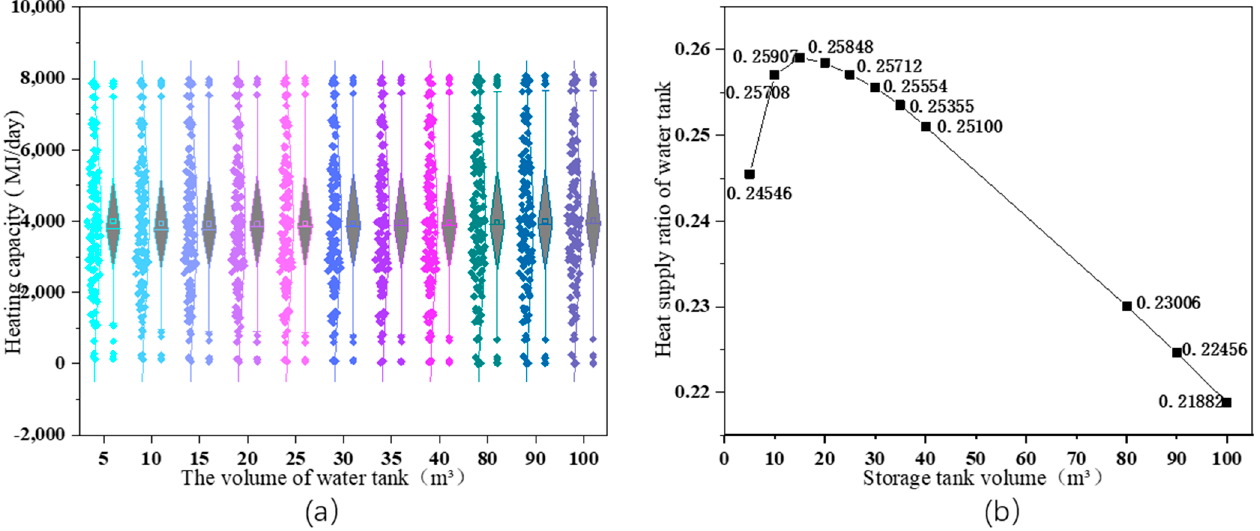
Figure 7. SHS with different specifications of HSWTs: ( a ) a block diagram of the daily heat supply of AHS; ( b ) the proportion of heat provided by the HSWTs throughout the heating season.